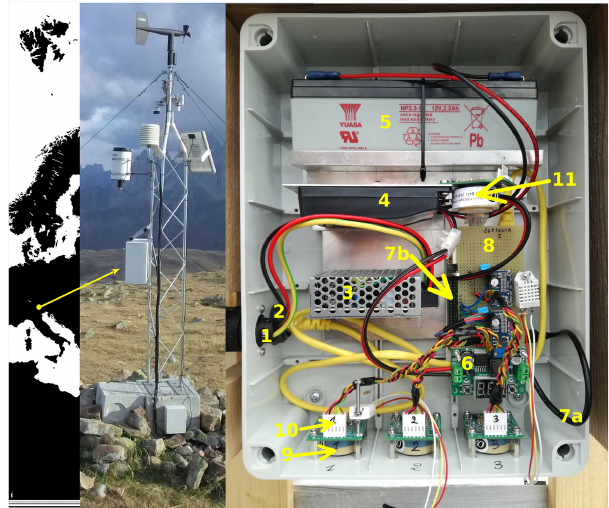
Figure 2. The low-cost sensing system and its components. (1) AC power in, (2) ethernet, (3) power supply, (4) charge regulator, (5) battery, (6) DC/DC converter, (7a) USB power wire, (7b) Rasp- berry Pi, (8) data acquisition board, (9) working sensor, (10) sen- sor’s plug and (11) spare